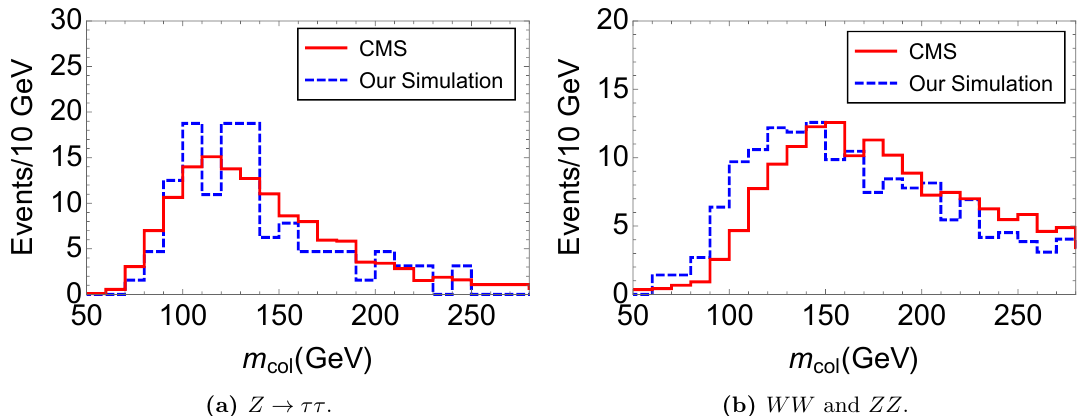
1 luminosity from our simulation (cid:0)